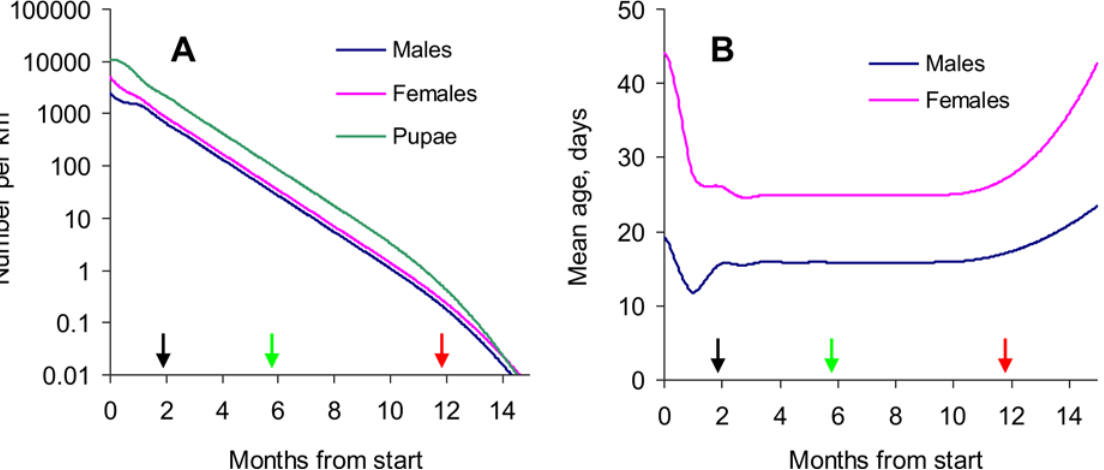
Fig 3. Time course of population change during standard steady control in good isolated habitat. Effects of targets that kill 5% of the adult population per day, and are maintained continuously at maximum performance against a standard population of tsetse in an isolated area of good habitat: (A) effects on the numbers of pupae and adult males and females per km 2 , and (B) mean age of adult males and females. Arrows indicate when the control of adult male plus female tsetse reached 90% (black arrow) and 99% (green), and when the population began to collapse due to inadequate availability of mates